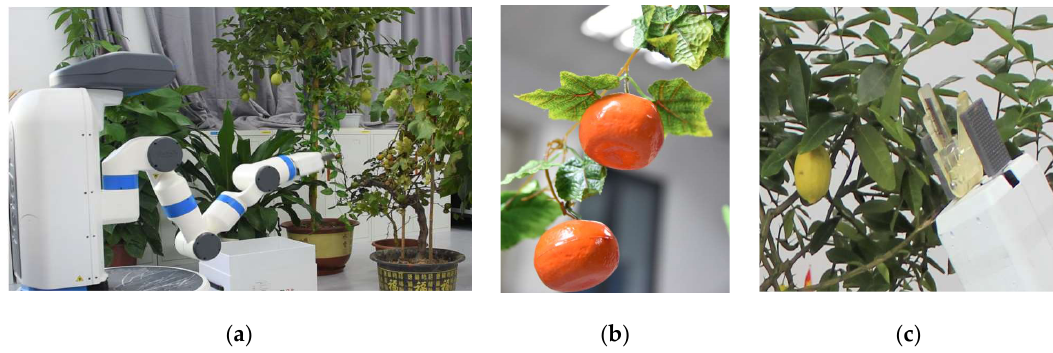
Figure 9. Setup for the experiments. ( a ) The experiment setup; ( b ) The plastic crops with plastic peduncles hung on a rope; ( c ) The proposed gripper mounted on the end-effector of the Fetch